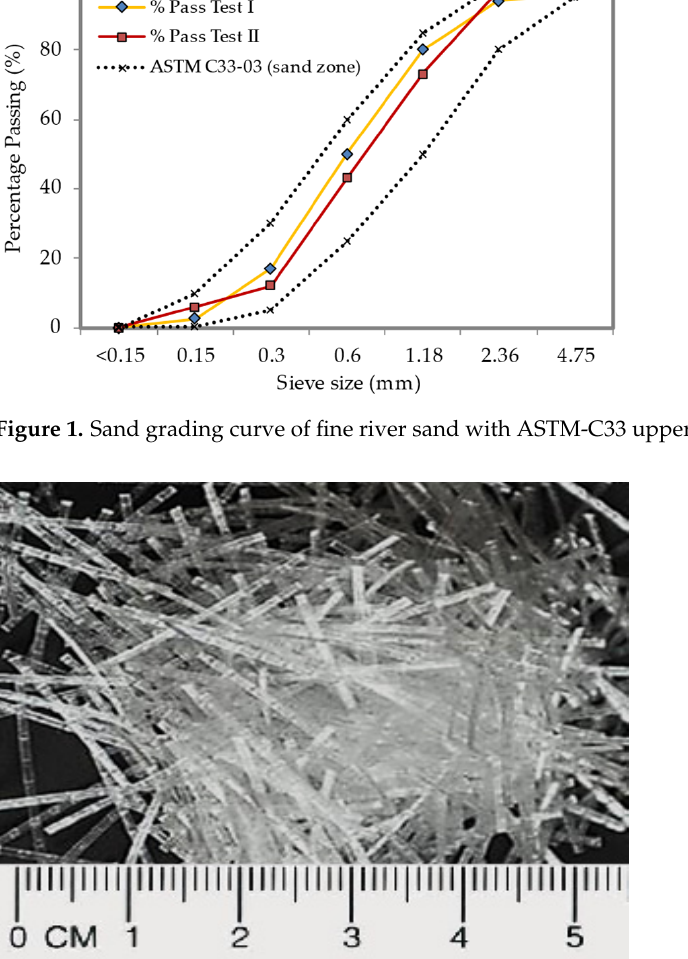
Figure 2. Polypropylene fibrillated fiber (PFF).